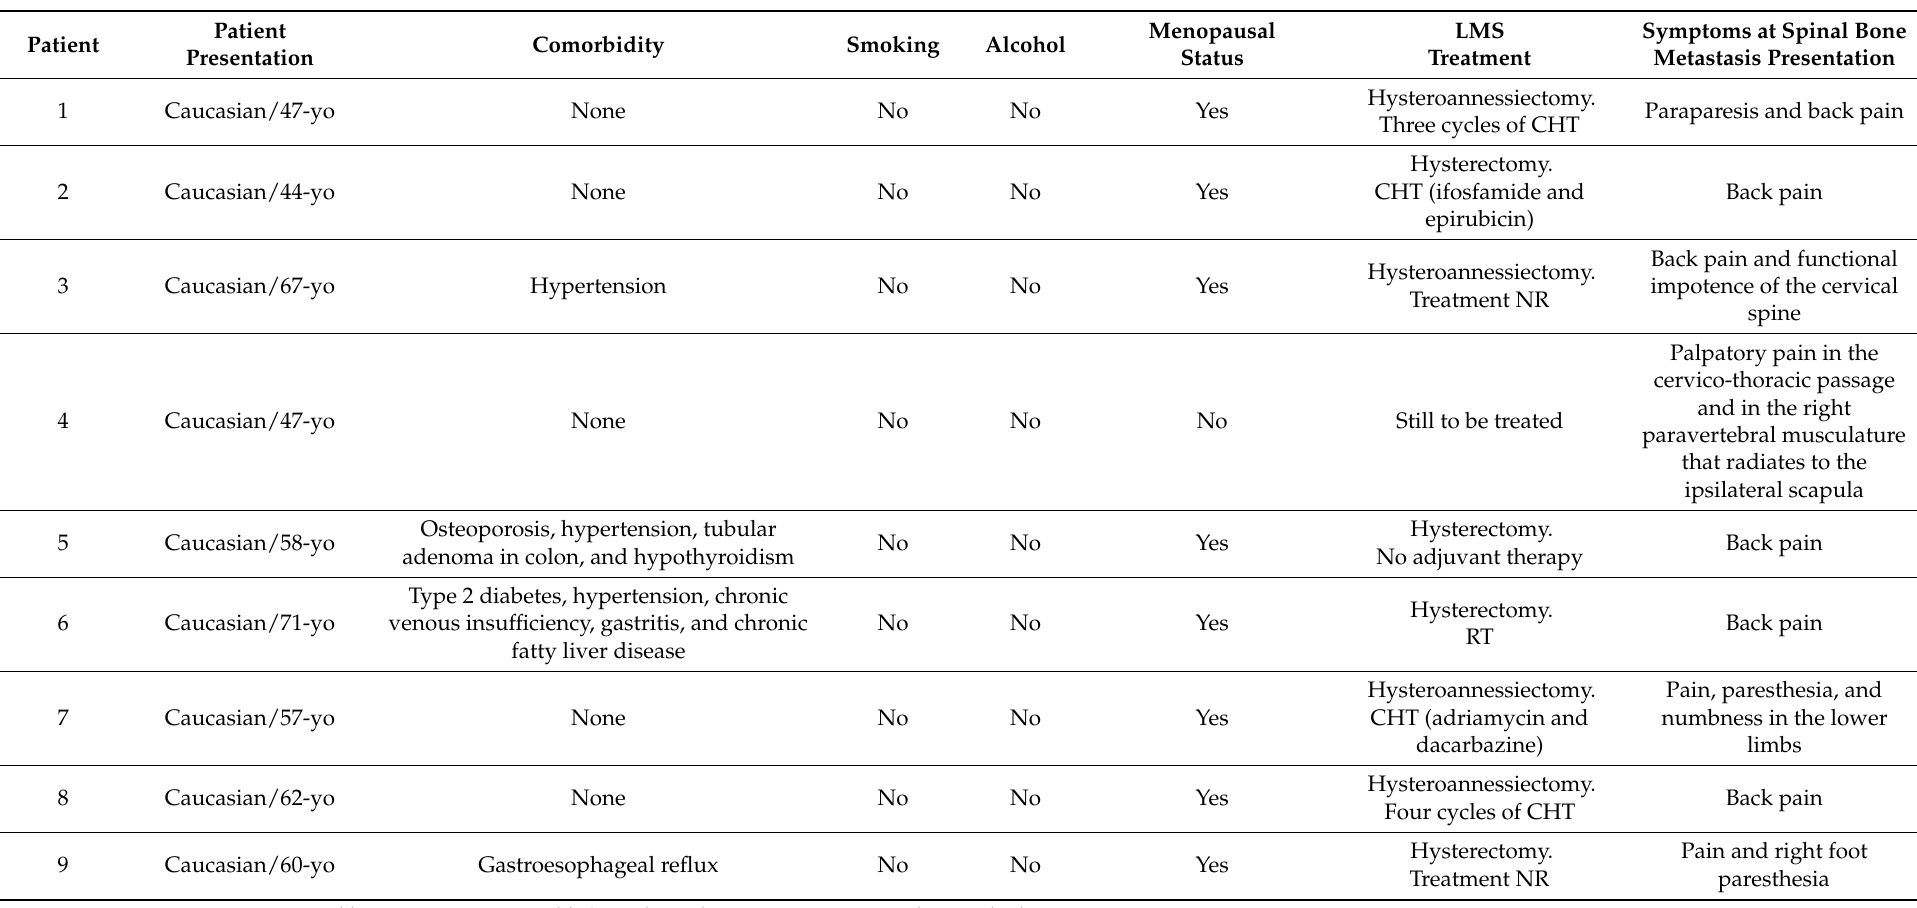
Table 2. Patients’ individual general characteristics (n =